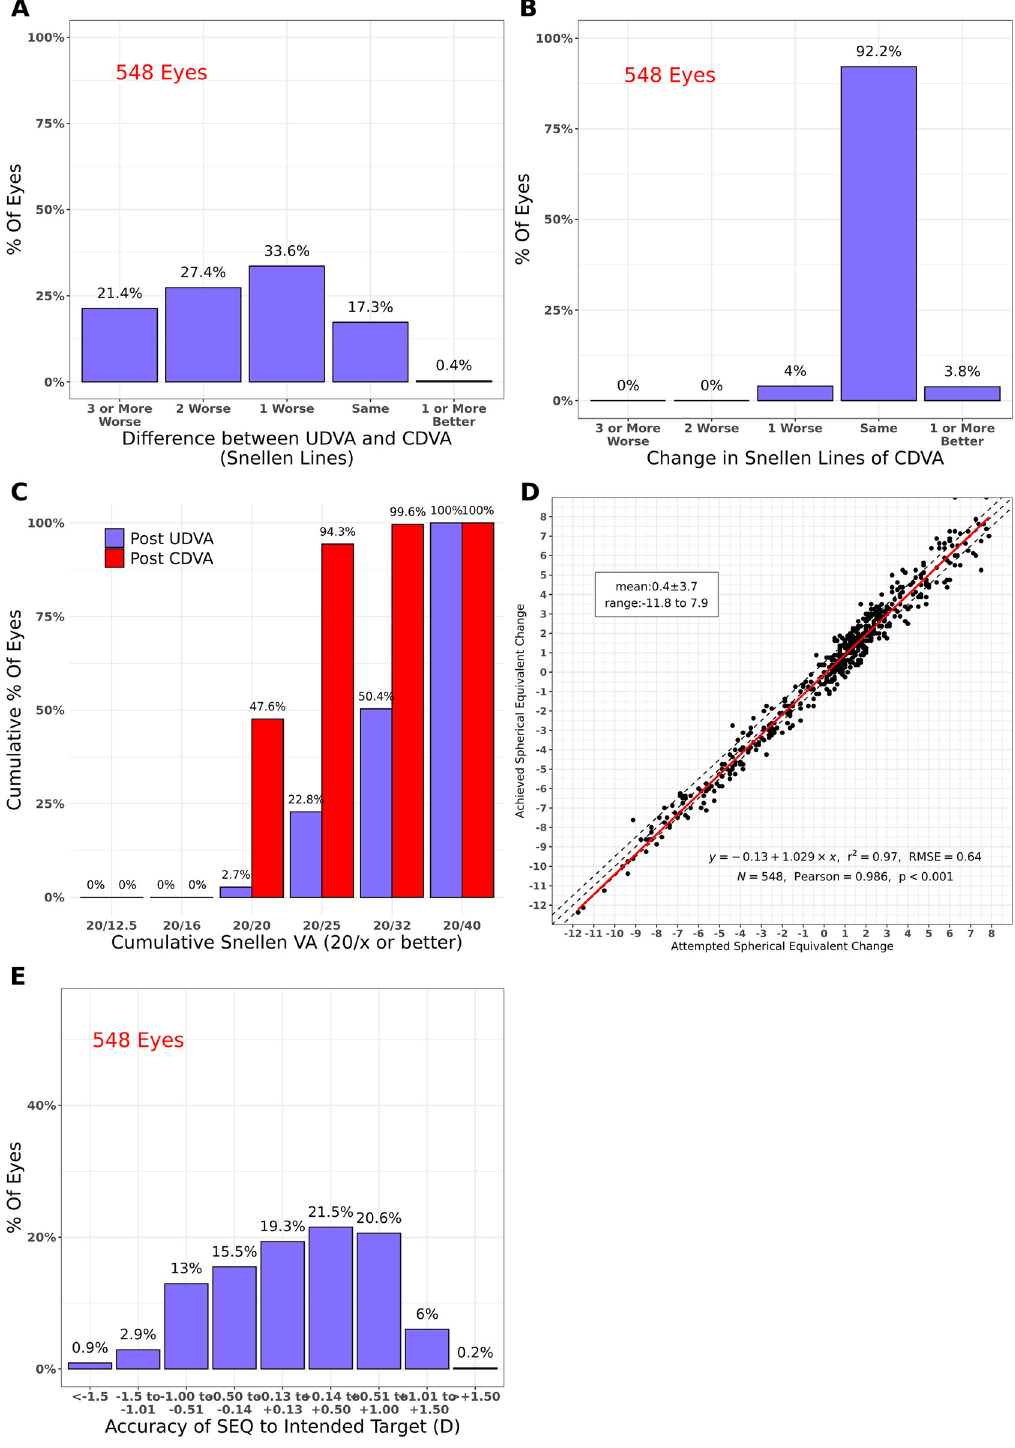
Fig 1. Standard graphs reporting visual outcomes: Preoperative vs postoperative (MIOL implantation). UDVA: uncorrected distance visual acuity, CDVA: corrected distance visual acuity, VA: visual acuity, SEQ: spherical equivalent, D: diopter(s), r 2 : coefficient of determination, RMSE: root mean squared error, N: number of eyes, Pearson: Pearson Correlation Coefficient.